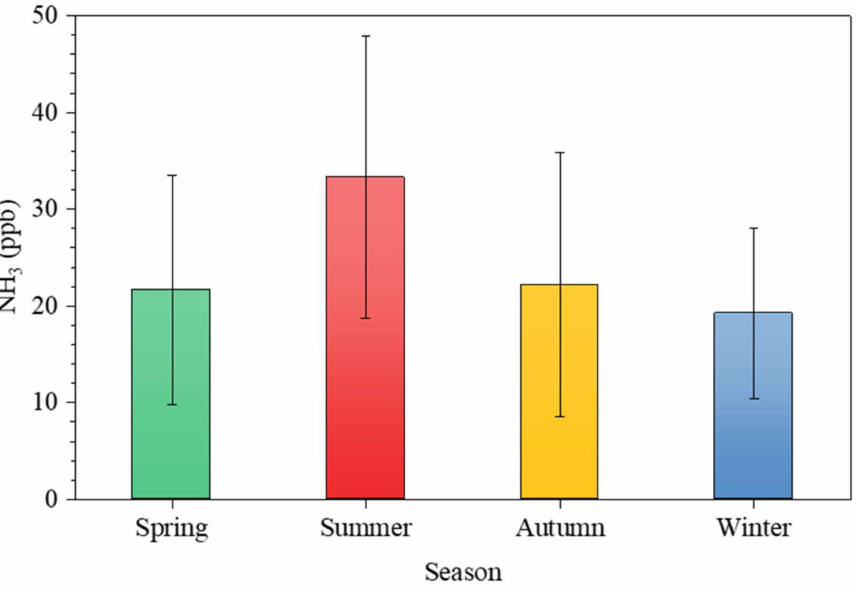
Figure 3. Seasonal variations in the average atmospheric NH 3 at rural sites R2 and R3 from September 2019 to August 2020. Each error bar indicates the standard